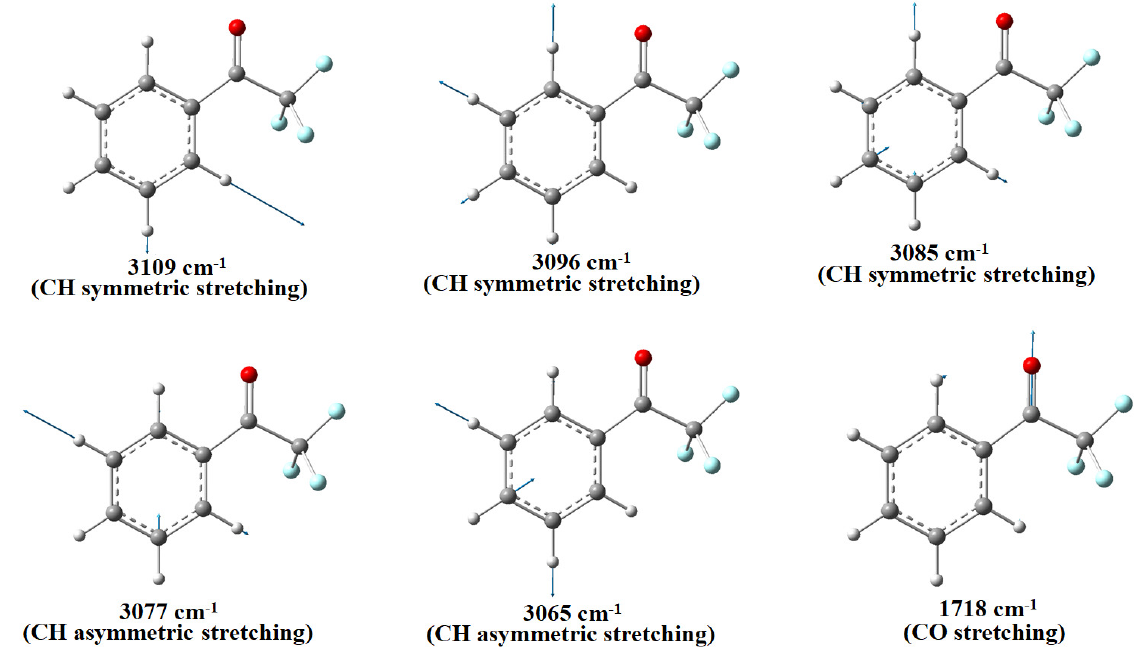
Figure 6. Displacement vectors corresponding to C-H and C=O vibrational modes of